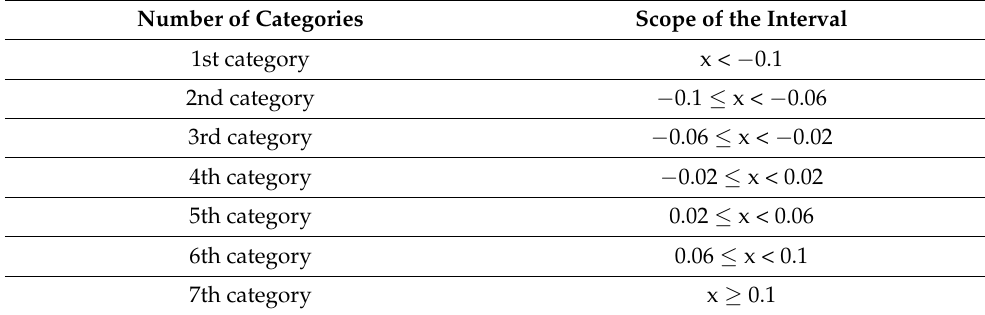
Table 1. Categories of factor